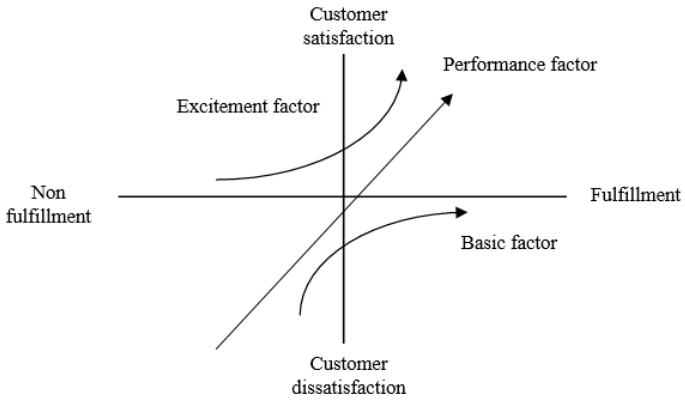
Figure 1. Revised importance–performance analysis (RIPA) Perceptual Map.